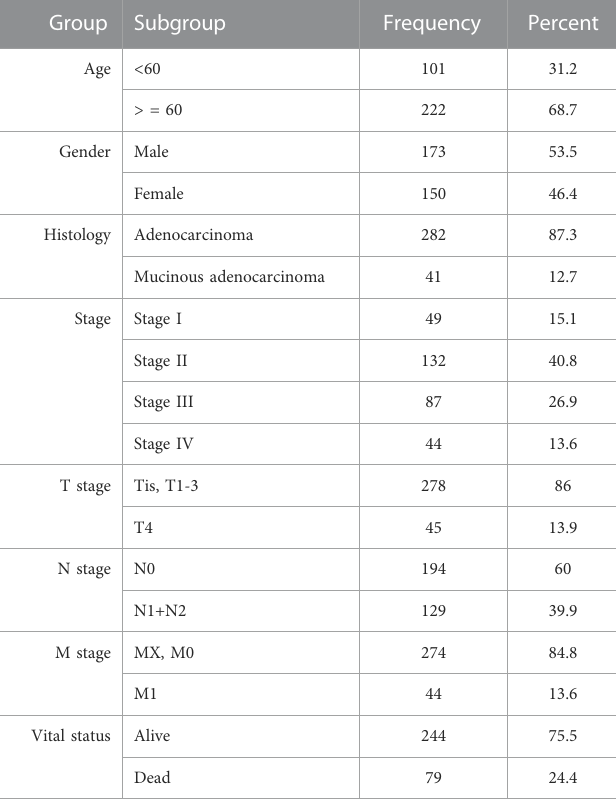
TABLE 1 Clinical parameters of colon cancer